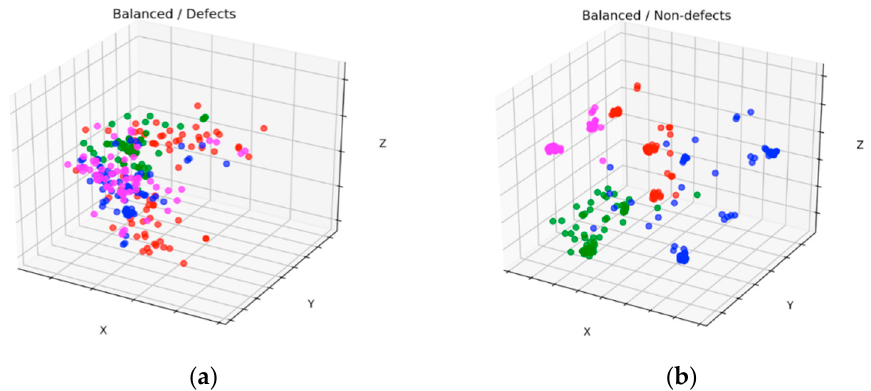
Figure 12. Scatter comparisons of the training dataset with four clusters for ( a ) defects and ( b ) non- defects in the balanced method.